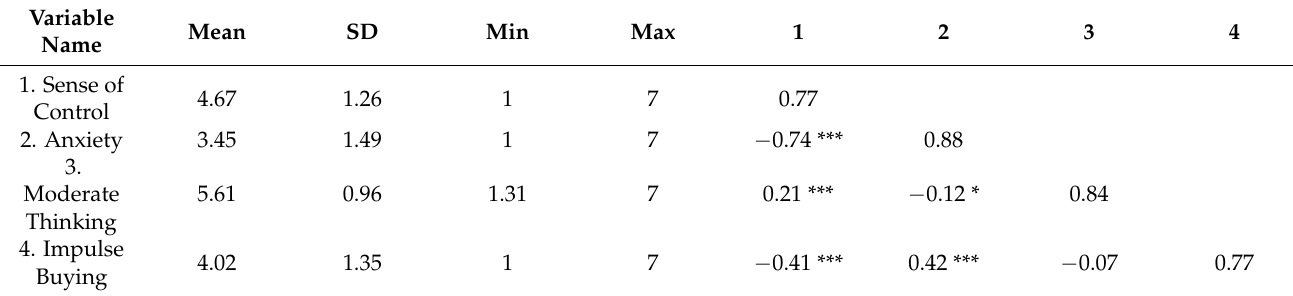
Table A2. Descriptive statistics and correlations of Study